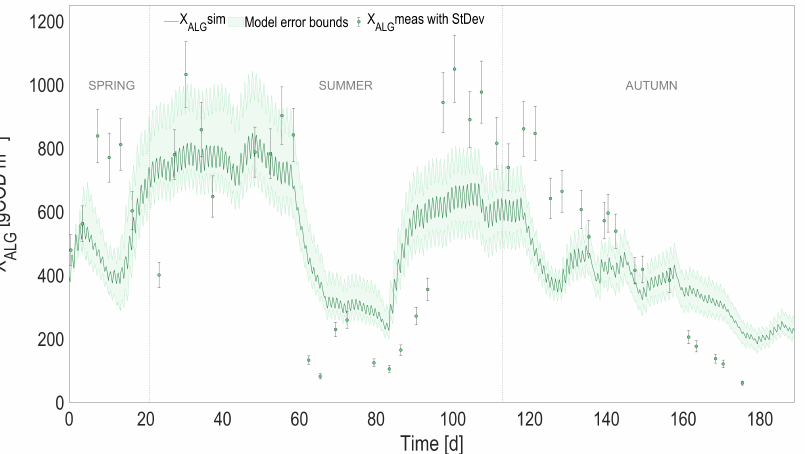
Figure 7. Full prediction capability of the coupled heat transfer and ALBA models. Comparison between full predictions (with simulated temperature) and measurements, for algal biomass ( X ALG ). Shaded areas on model predictions represent the related 95% confidence